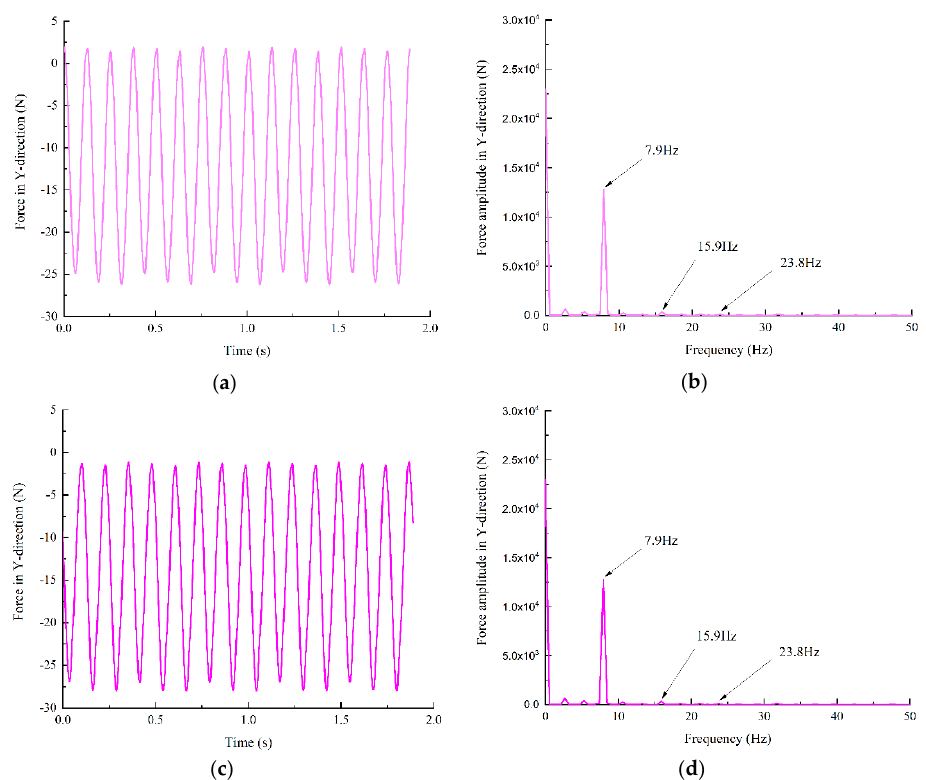
Figure 20. Aerodynamic loads acting on blades of the ( a ) H ‐ type and ( c ) hybrid VAWTs in the Y ‐ direction and their dominant excitation frequencies for the ( b ) H ‐ type and ( d ) hybrid VAWTs.